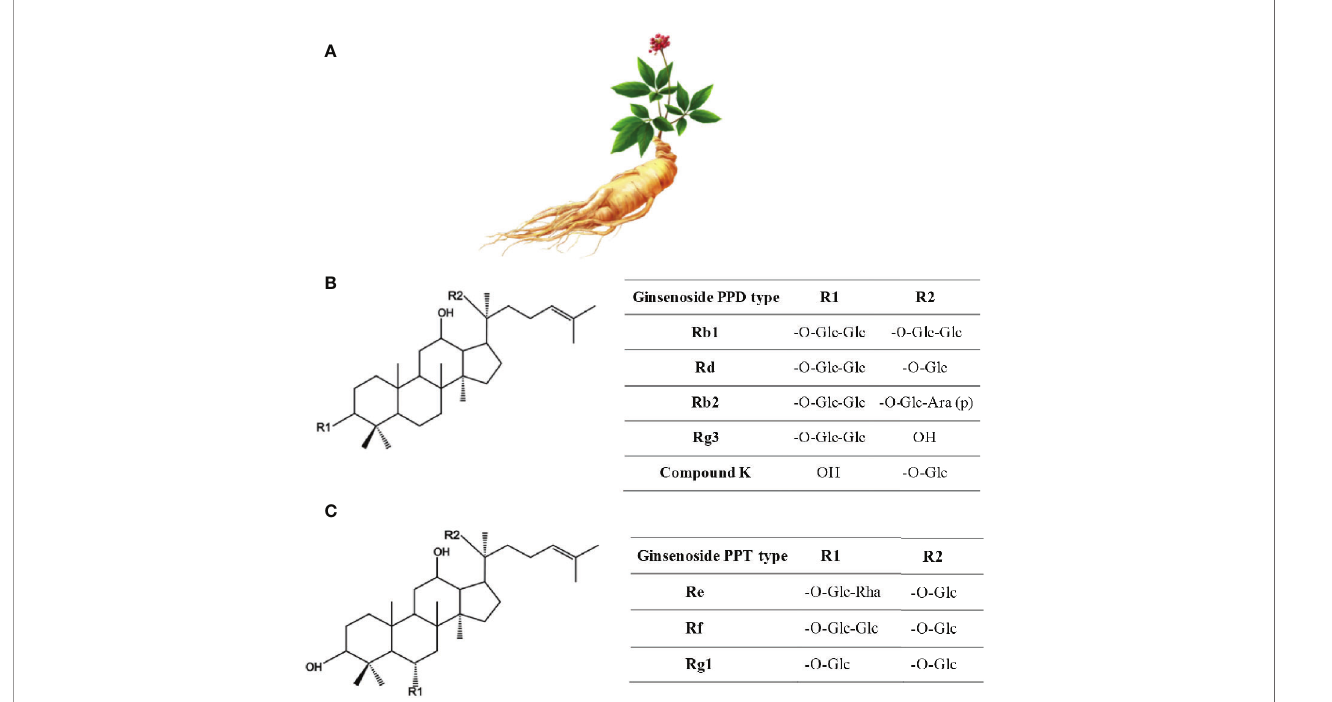
FIGURE 2 | Ginseng. (A) Roots have the healing properties (from https://pngtree.com/freepng). (B) Chemical structure of Ginsenosides. (C) Ginsenosides protopanaxadiol (PPD) and Ginsenoside protopanaxatriol (PPT). R1 and R2 are side chains in different ginsenosides. Glc, glucose; Ara, arabinose; Rha,